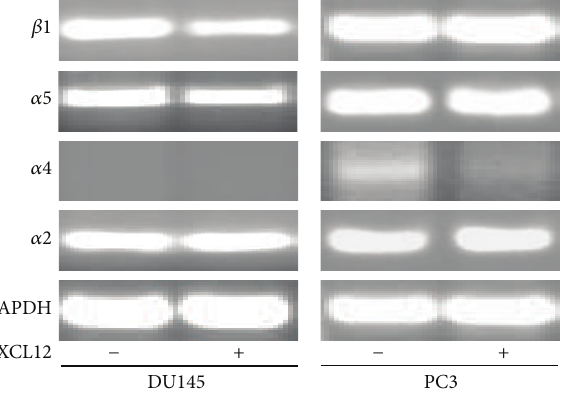
Figure 7: Ethidium bromide stained agarose gel electrophoresis of RT-PCR products of 𝛼 2, 𝛼 5, 𝛼 4, and 𝛽 1 integrin subunits in untreated and treated DU145 and PC3